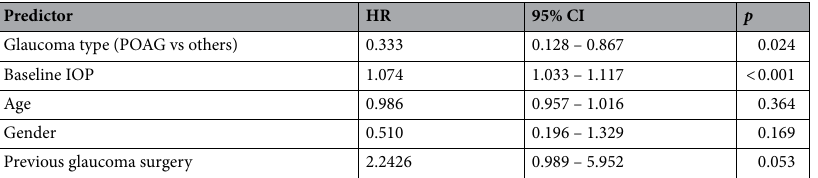
Table 2. Cox proportional hazard regression analysis of rate of treatment failure. HR hazard ratio, CI confidence intervals, POAG primary open-angle glaucoma, IOP intraocular